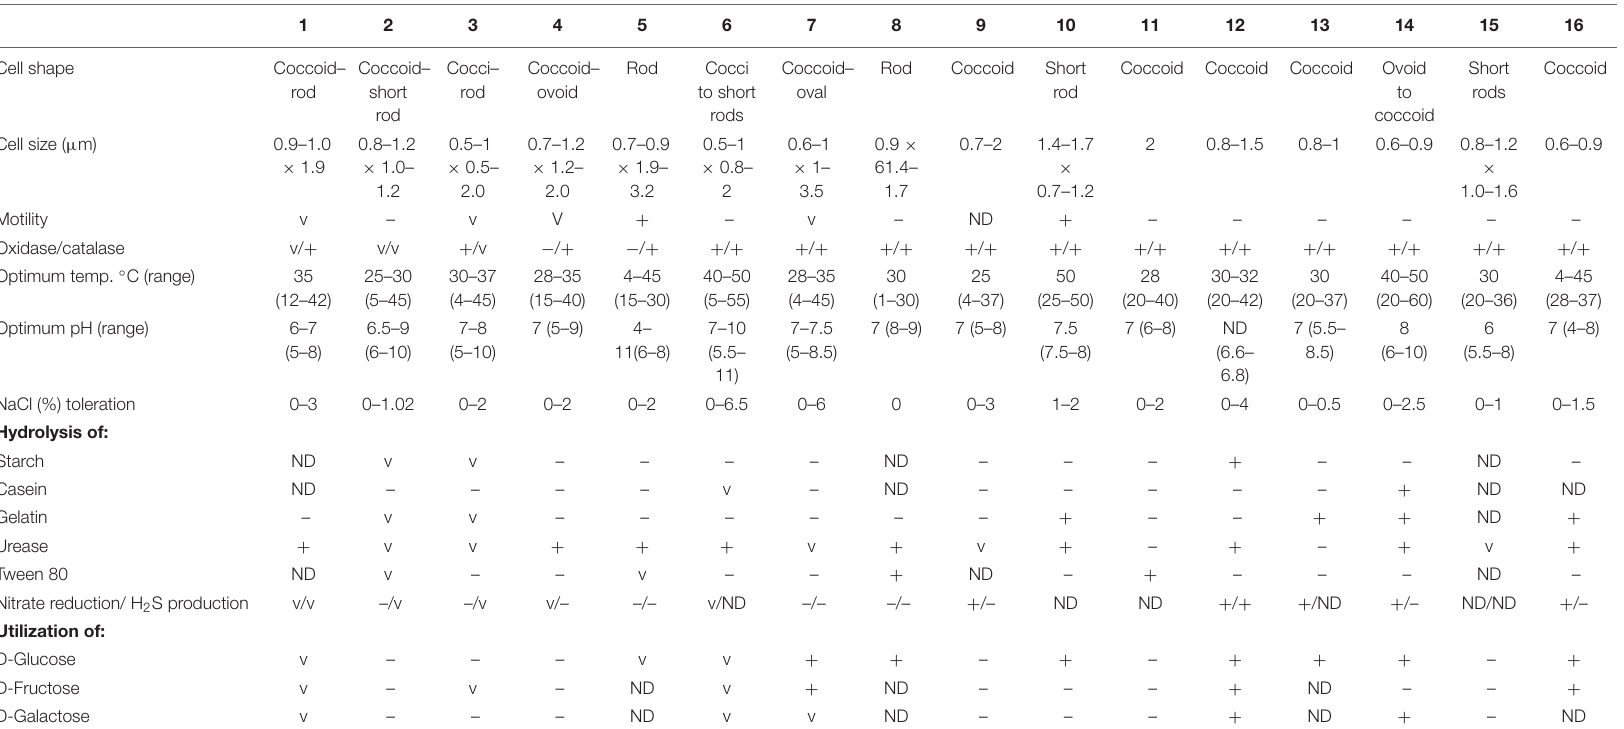
TABLE 2 | Characteristics differentiating the Roseomonas groups from other closely related genera in the family Acetobacteraceae